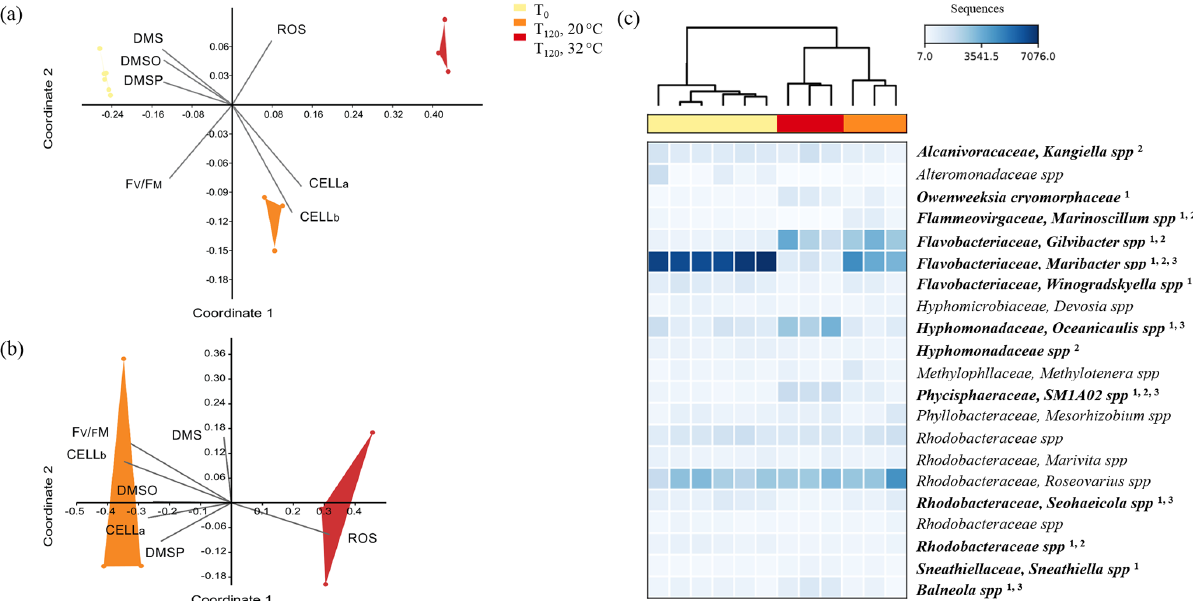
Figure 6. Multi-dimensional scaling (MDS) of the three phylogenetic groups defined by 16S rRNA sequencing of the bacteria population associated with A. minutum cultures grown under control conditions (20 ◦ C) and acute thermal stress (32 ◦ C) at T 0 and T 120 (a) and MDS excluding the T 0 control (b) . Vectors represent the factors that most likely drove the shift in bacterial composition between groups. The taxonomic groups that significantly contributed to the difference in bacterial composition between T 0 and T 120 at 32 ◦ C ( 1 ), between T 0 and T 120 at 20 ◦ C ( 2 ) and between 32 and 20 ◦ C at T 120 ( 3 ) appear in bold next to the heatmap (c) , with scaling based on relative